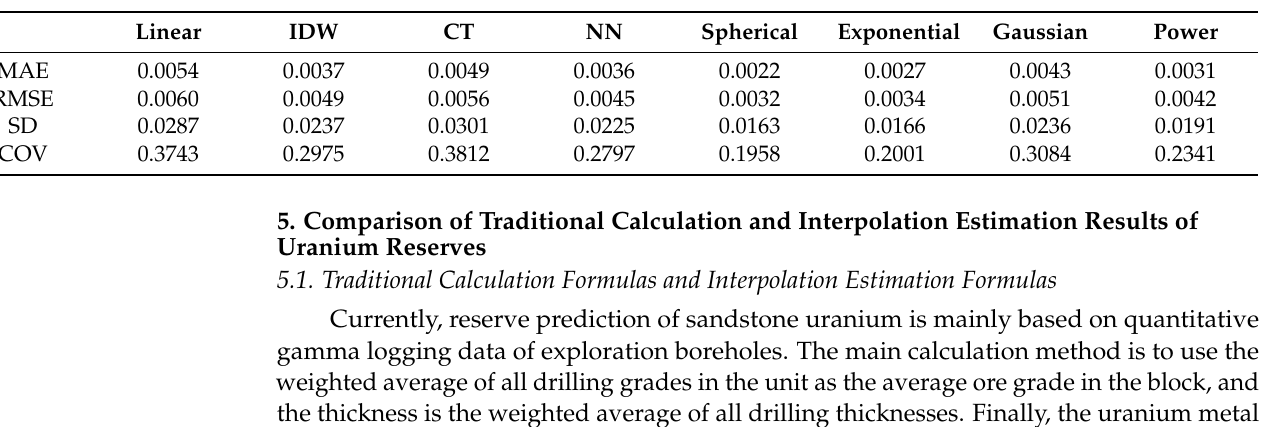
Table 3. Error analysis after cross-validation of uranium